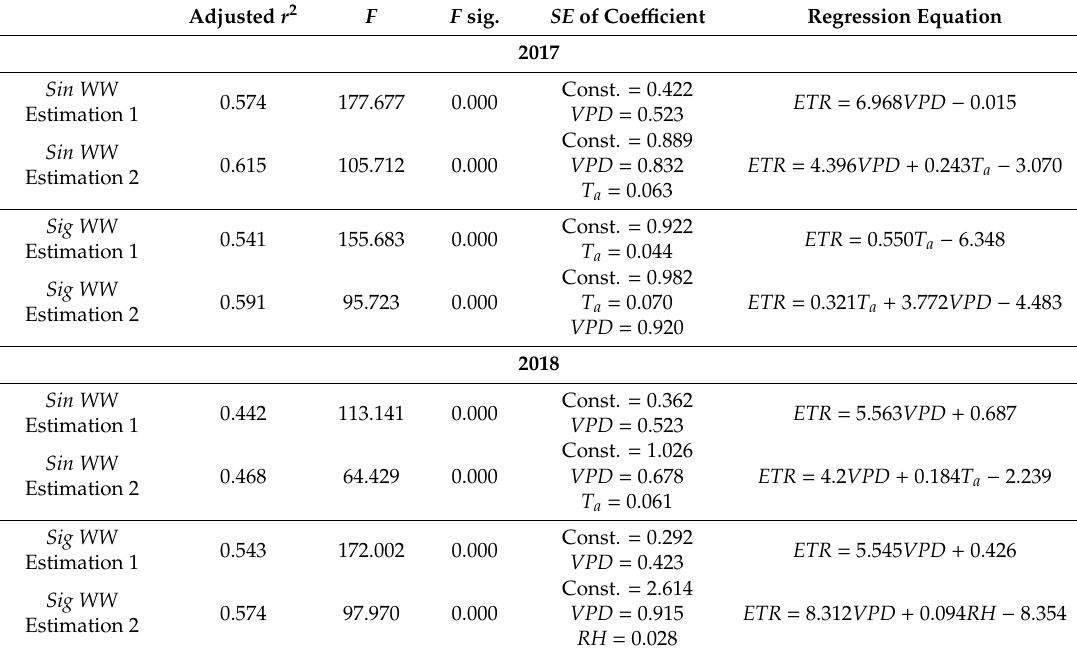
Table 6. Multiple stepwise regression analysis between meteorological elements (air temperature, T a ; relative humidity, RH ; net radiation, R s ; wind speed, u ; vapor pressure deficit, VPD ) and measured soybean evapotranspiration rate ( ETR ) in varieties Sinara ( Sin ) and Sigalia ( Sig ). WW denotes unlimited watering. F